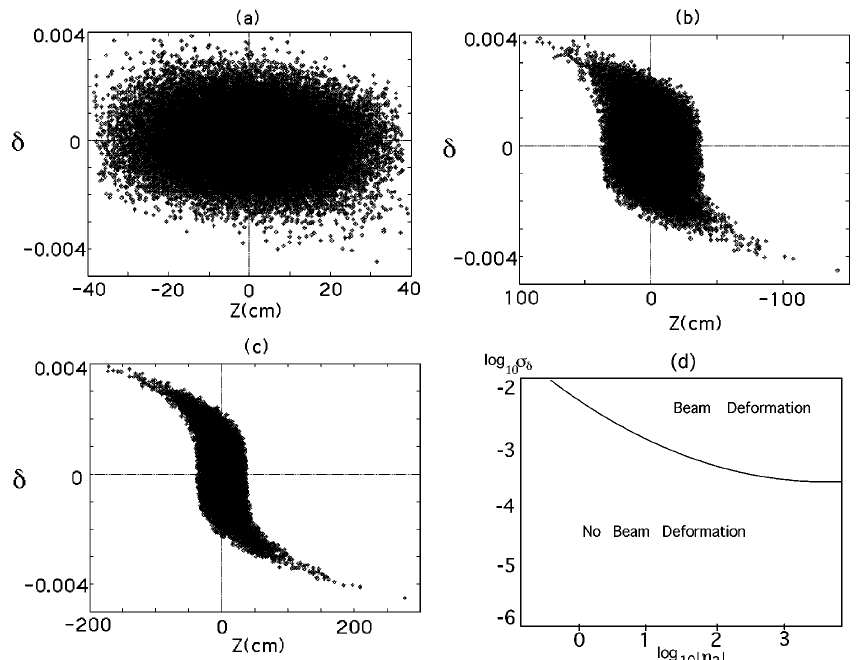
FIG. 10. The longitudinal phase space after 1000 turns for (a) h (cid:51) (cid:173) (cid:49)(cid:48) , (b) h (cid:51) (cid:173) (cid:53)(cid:48) , and (c) h (cid:51) (cid:173) (cid:49)(cid:48)(cid:48) . Two cavities are used to compensate for bunch wake. s d (cid:173) (cid:51) 3 (cid:49)(cid:48) 2 (cid:53) , h (cid:49) (cid:173) 2 (cid:49) 3 (cid:49)(cid:48) 2 (cid:54) , h (cid:50) (cid:173) (cid:48) , and j (cid:90) k s d and h (cid:51) parameter space. The right upper parameter space shows the beam streaming in the positive or negative (cid:122)